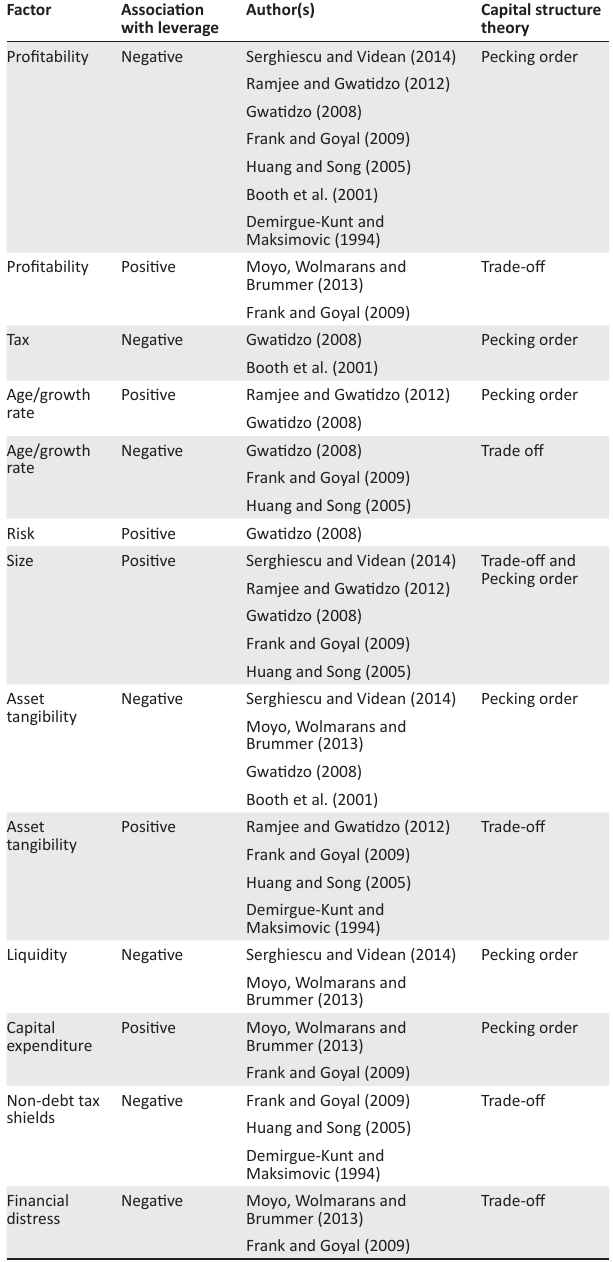
TABLE 1: Impact of capital structure determinants on capital